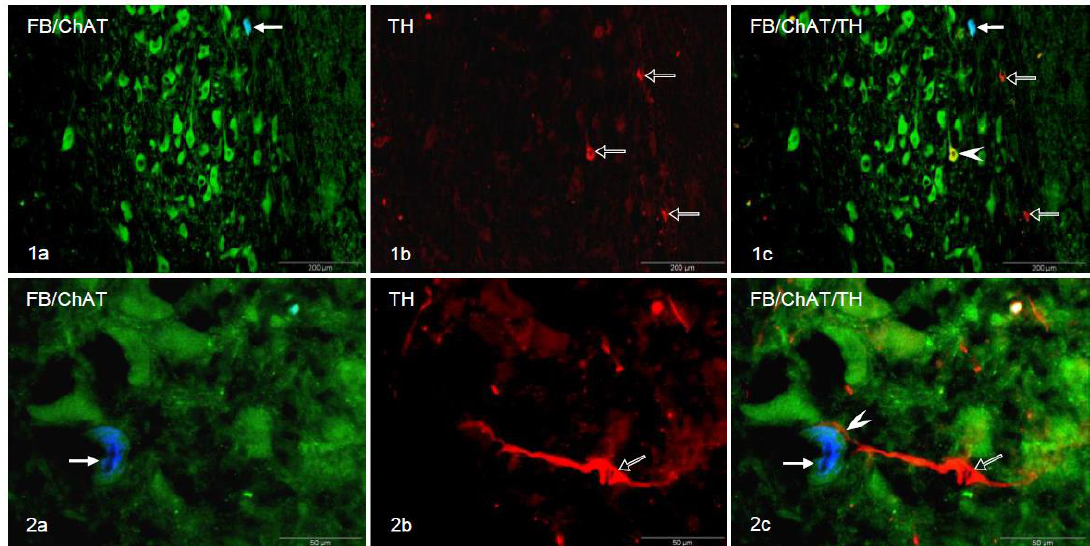
Figure 1. ( 1a ) Double-labeled FB + / ChAT + neuron (bold arrow) in the porcine DMX; ( 1b ) TH + neurons (empty arrows); ( 1c ) Digital superimposition of pictures in ( 1a , 1b ). Double-labeled FB − / ChAT + / TH + perikaryon (arrowhead), double-labeled FB + / ChAT + neuron (bold arrow) and TH + neurons (empty arrows) in the DMX. ( 2a ) Double-labeled FB + / ChAT + perikaryon (arrow) in the porcine DMX; ( 2b ) TH + neuron (empty arrow); ( 2c ) Digital superimposition of pictures in ( 2a , 2b ). TH + neuron (empty arrow) in close proximity of the FB + / ChAT + perikaryon (arrow). The arrowhead indicates the place of direct opposition of the TH + process on the FB + / ChAT + neuronal soma.